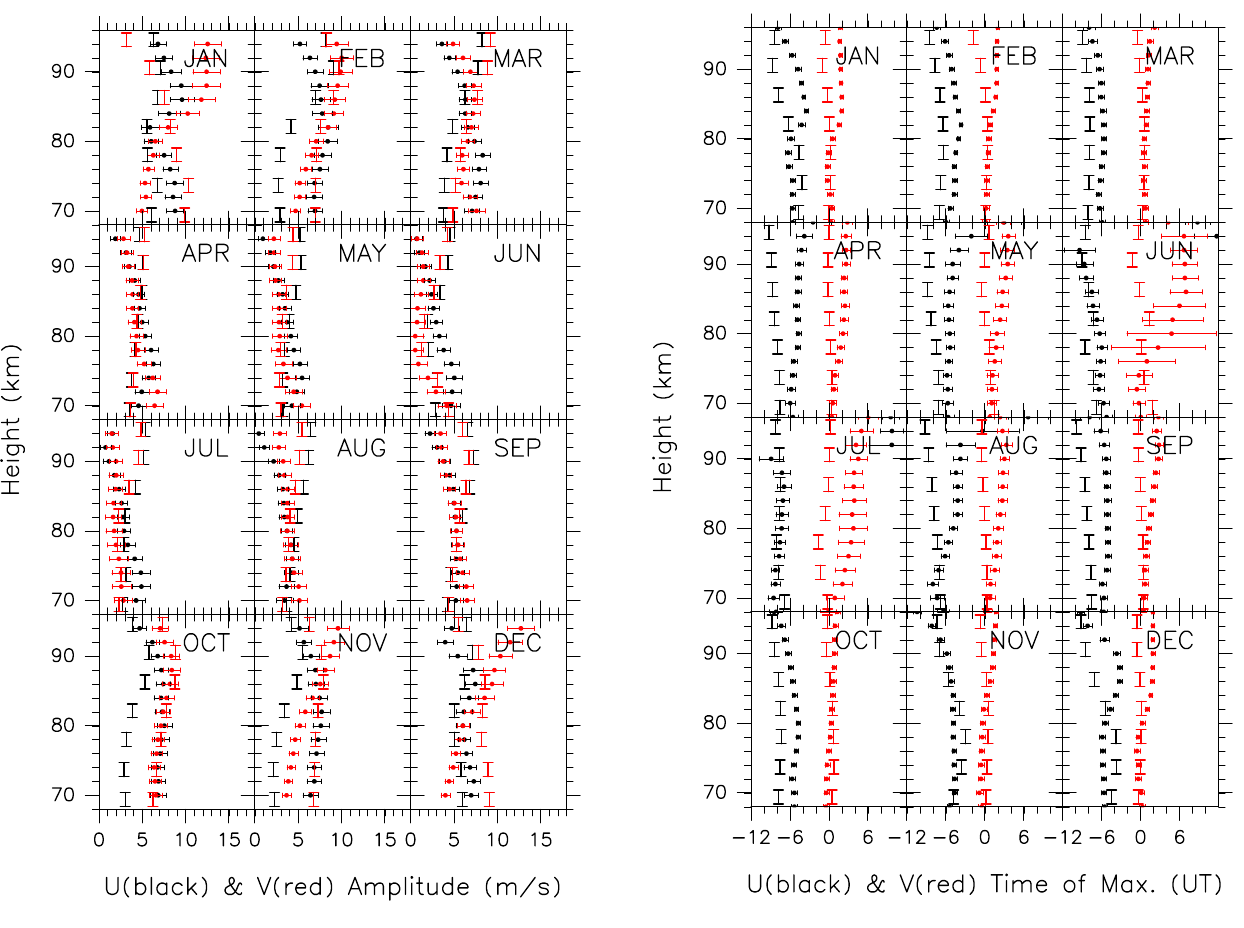
Fig. 2. Vertical distributions of diurnal amplitudes of zonal (black) and meridional (red) winds at Syowa for each month averaged over 1999–2008. Circles and “I” represent the MF radar and GSWM-02 data, respectively. 2 σ error bars are plotted for the MF radar data.